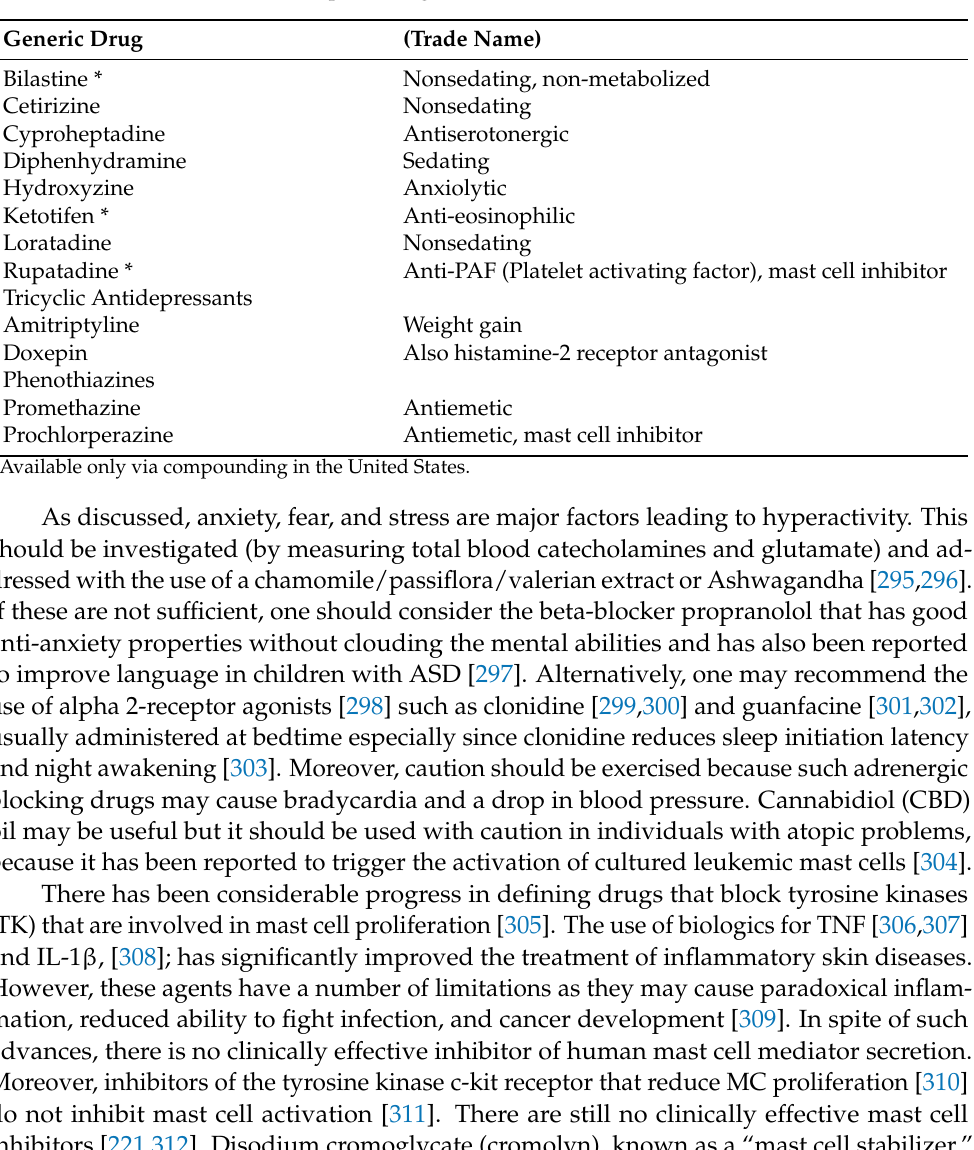
Table 4. Different histamine-1 receptor